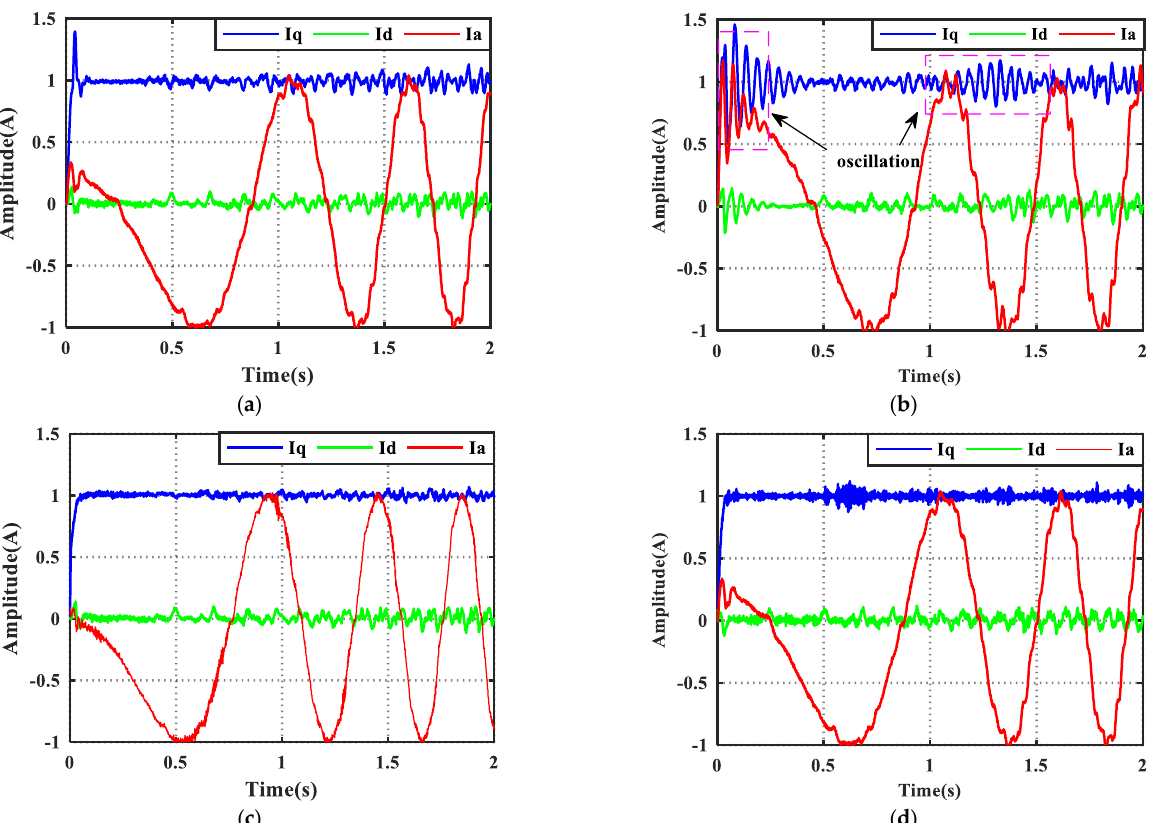
Figure 16. Step response comparison results: ( a ) with a PI controller, ( b ) With a PIR controller, ( c ) with the proposed Robust-TDOFR controller ( L = L 0 , R = R 0 ) and ( d ) with the proposed Robust-TDOFR controller ( L = 3 L 0 , R = 6 R 0